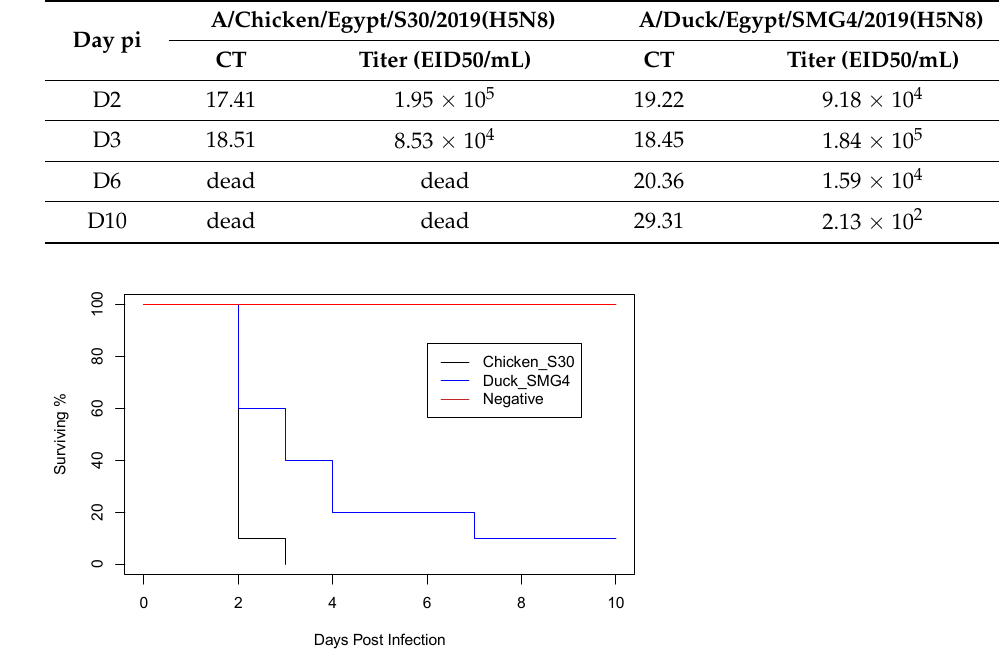
Table 1. Virus detection in infected groups of chickens. Table presents mean values detected from swab samples collected from inoculated chickens.